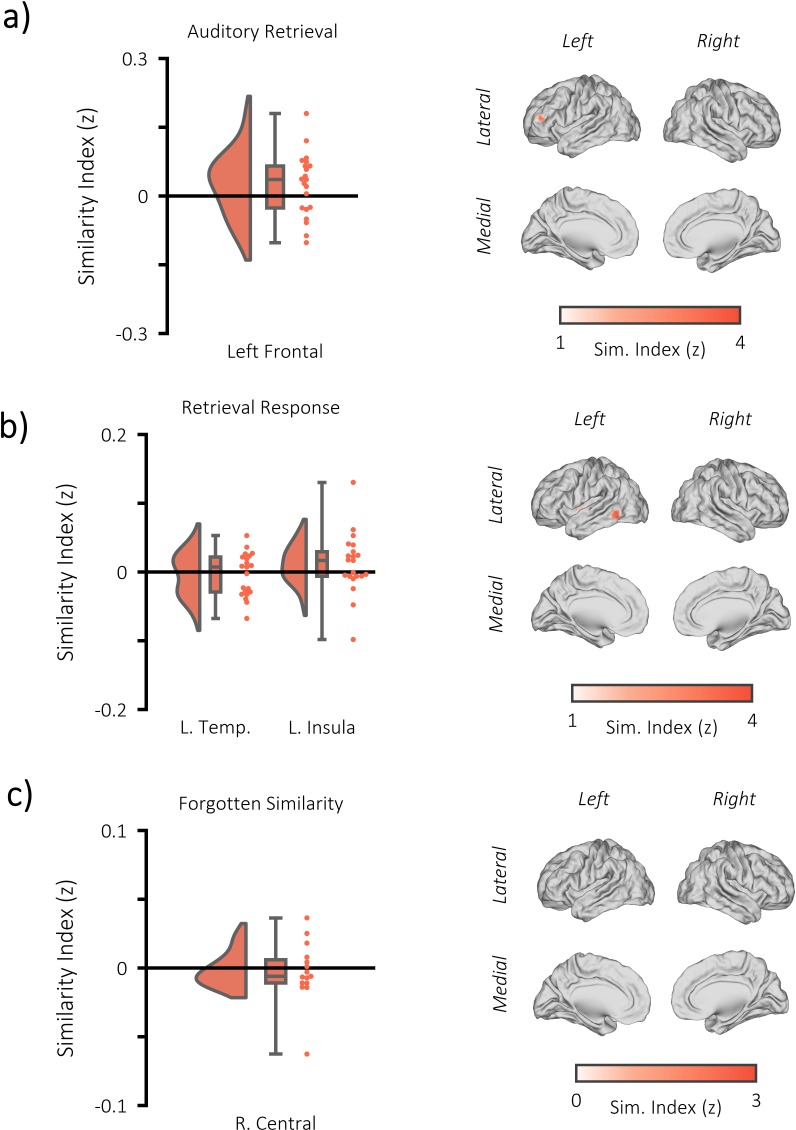
Additional fMRI RSA searchlight analysis.(a) raincloud plot (left) depicting the degree to which matching and differing stimuli could be distinguished from one another during auditory memory retrieval, per participant (single dots), within the significant cluster, and brain map (right) depicting the cluster where matching and differing stimuli could be distinguished from one another. The left frontal cluster did not pass threshold to be deemed statistical significant (p=0.153, k = 28, MNI = [x = −39, y = 44, z = 14]). (b) raincloud plot (left) and brain map (right) for stimulus discriminability during the response period of the memory retrieval task (when still images of the stimuli were presented on screen [approximately 3 s after the retrieval cue]). Two significant clusters were identified (left temporal: p=0.002, k = 70, MNI = [x = −39, y = 44, z = 14], Cohen’s dz = 0.12; left insula: [=0.013, k = 49, MNI = [x = −36, y = −4, y = −2], Cohen’s dz = 0.27). However, neither overlapped with the fusiform clusters identified during the moment of visual memory retrieval, suggesting the still images did not drive the reported encoding-retrieval pattern similarity effect. (c) raincloud plot (left) and brain map (right) for encoding-retrieval similarity of forgotten stimuli. One cluster was formed, but did not pass threshold for significance (right central: p=0.681, k = 13, MNI = [x = 39, y = −7, z = 66], Cohen’s dz = 0.13).